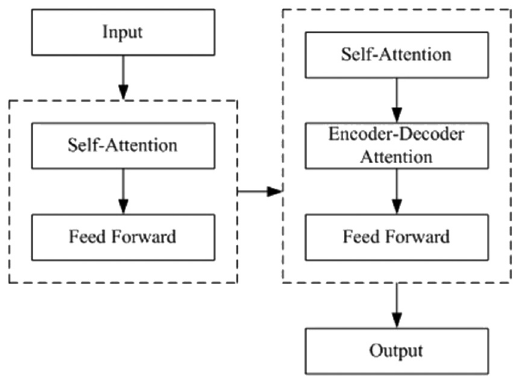
Figure 1: The structure of the Transformer